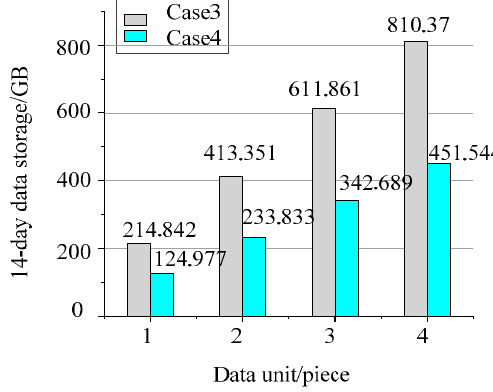
Figure 15. Fourteen days of data storage for two cases.